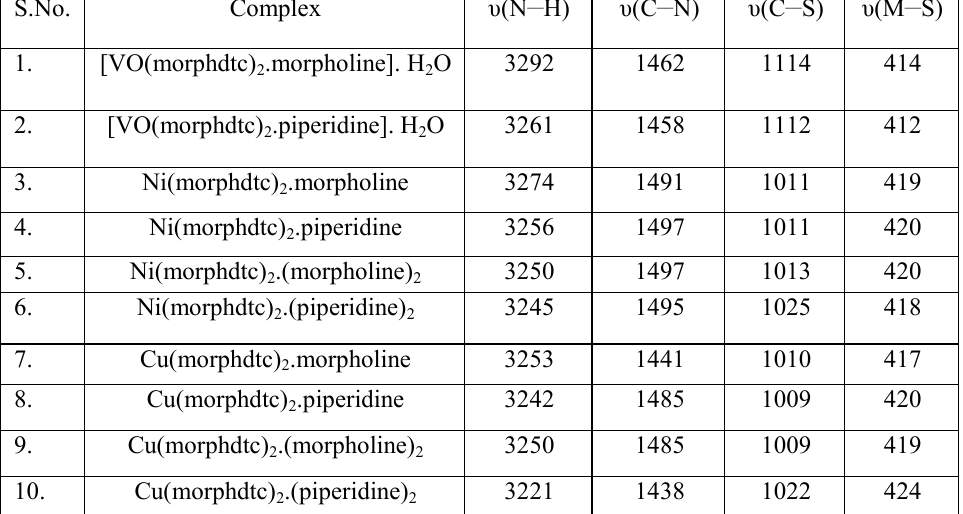
Table 2. Important IR spectral bands (cm –1 ) and their